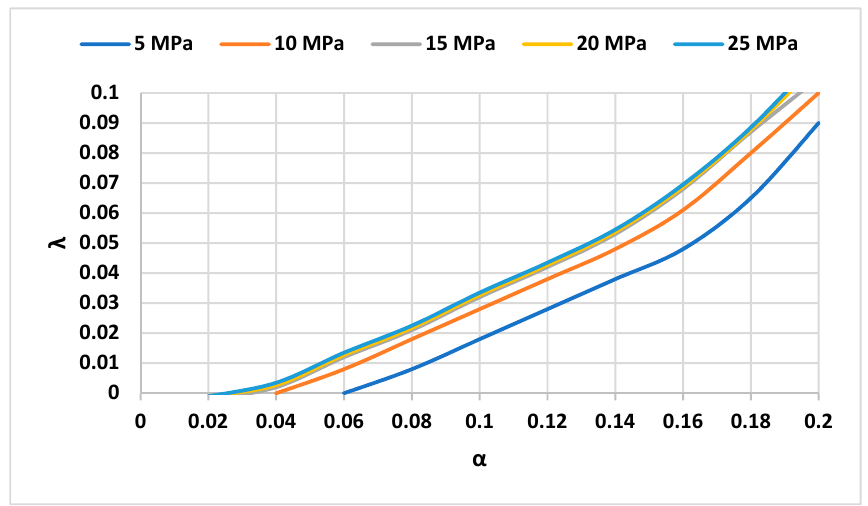
Figure 8. Changes of λ at different operating pressures compared to low values of α .